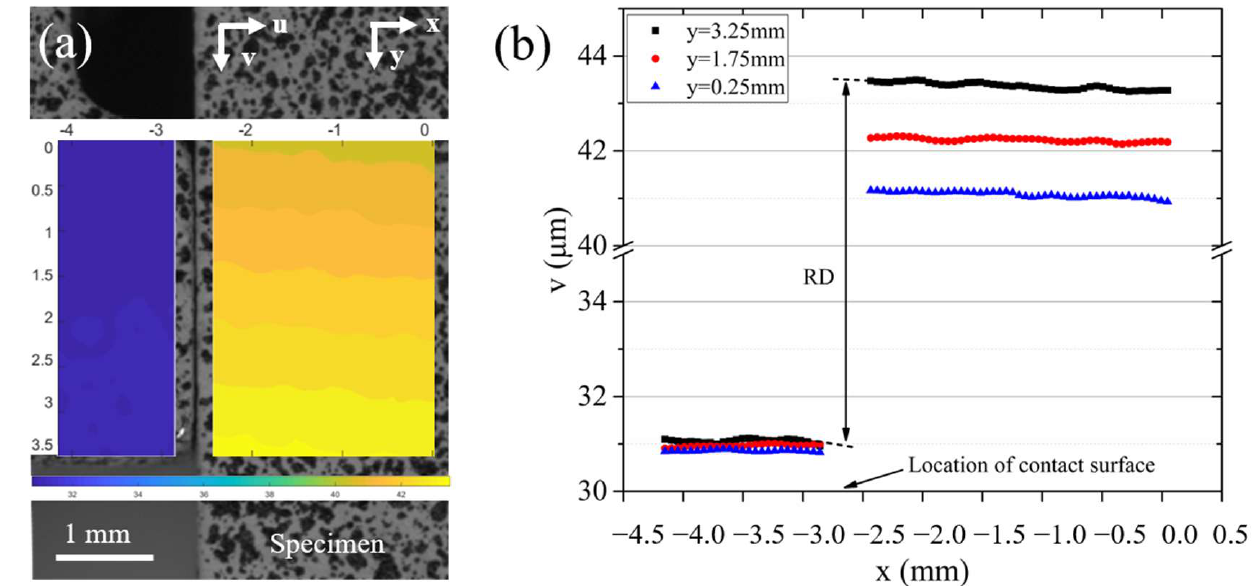
Figure 7. ( a ) Vertical displacement cloud of the observation area and ( b ) distribution of vertical displacement along the x-direction for the 7.3 kN case (cycle 1).